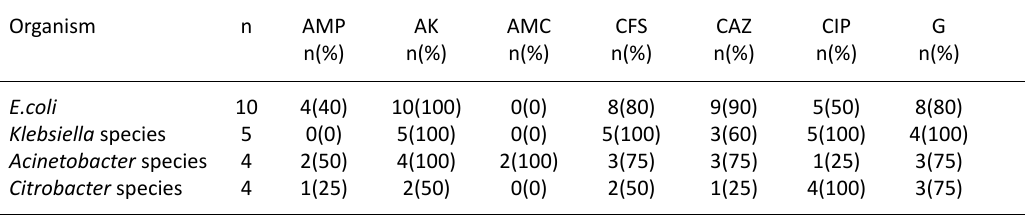
table 4. Antibacterial Susceptibility pattern of Enterobacteriaceae members isolated from infertility patients as per CLSI guidelines